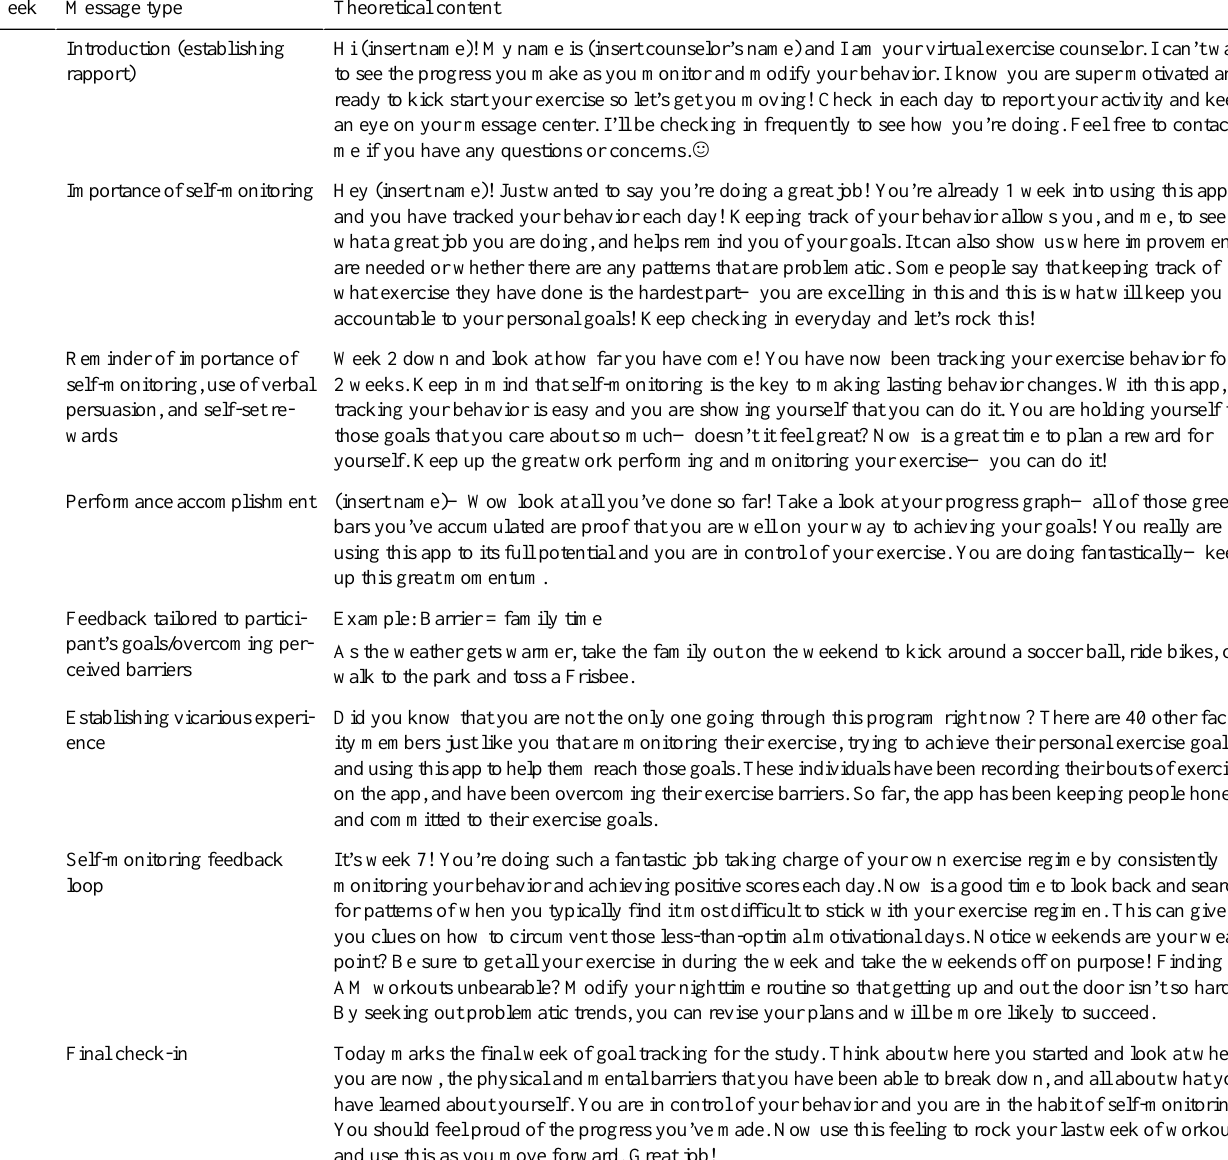
Theoretical contentMessage